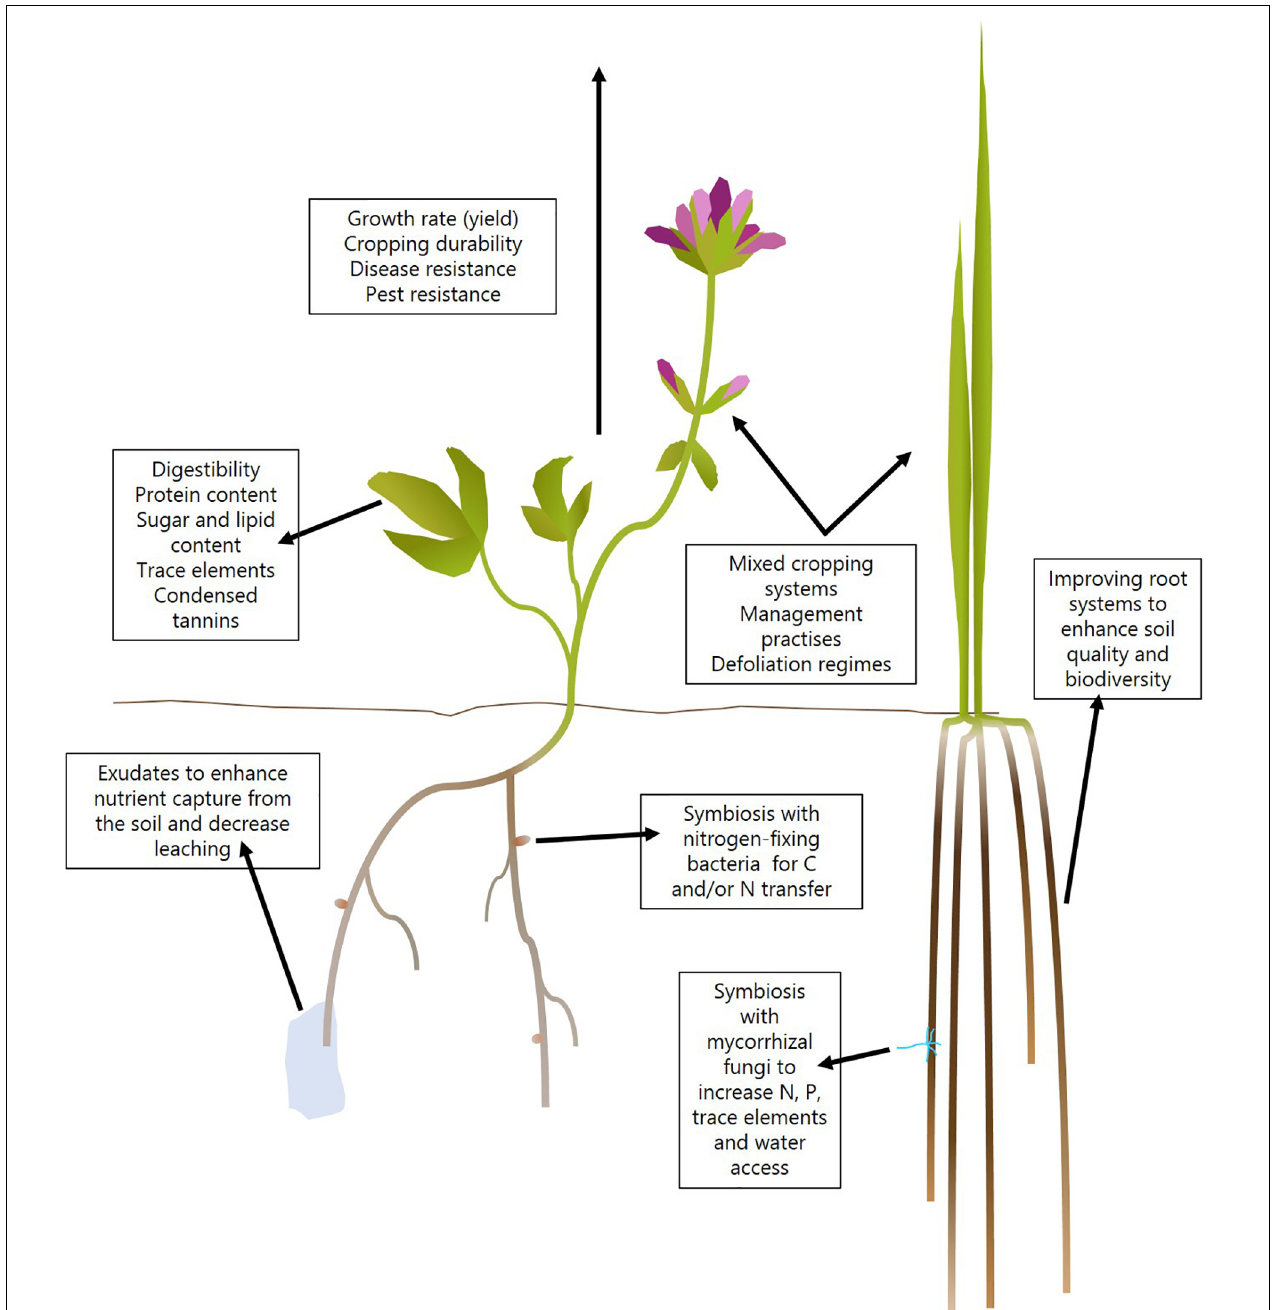
FIGURE 3 | Targets for improved forage